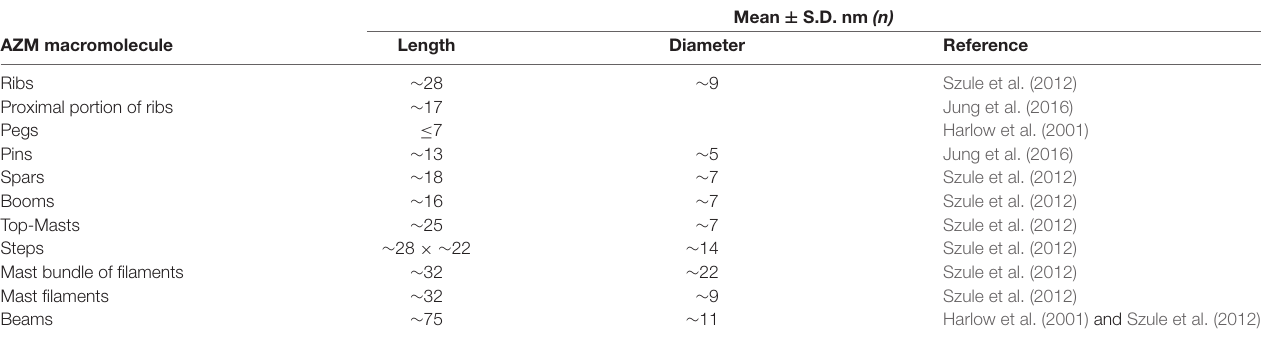
TABLE 1 | Dimensions of active zone material (AZM)